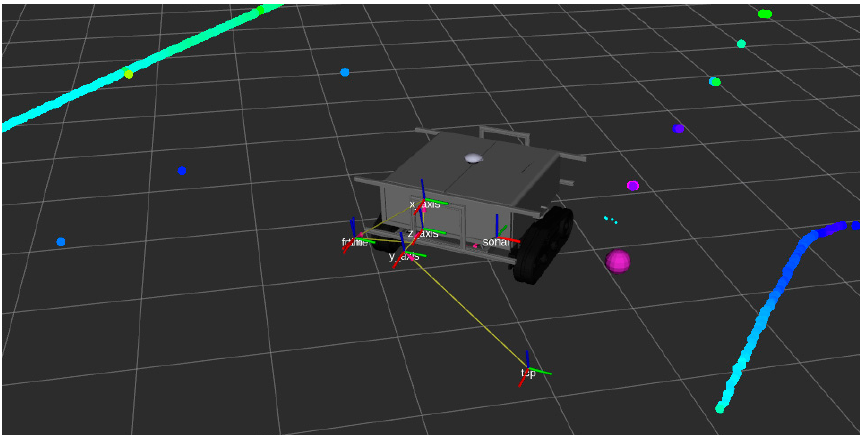
Figure 2. ROS-Software environment visualization “rviz” of robot position, implement position and the laser scanner points (small dots) and sonar data (purple ball).